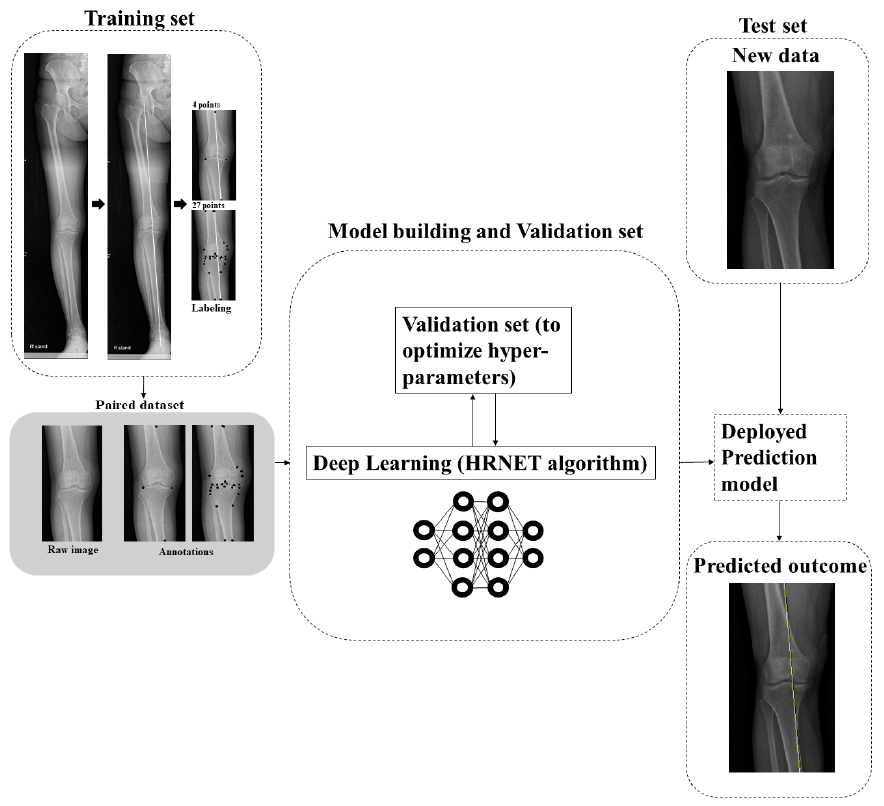
Figure 1. Pipeline of the study. Annotations: labeled image. Training set: the data sample used to fit the model. Validation set: the data sample used to provide an unbiased evaluation of a model fit on the training dataset while tuning the model hyperparameters. Test set: the data sample used to provide an unbiased evaluation of the final model fit on the training dataset.